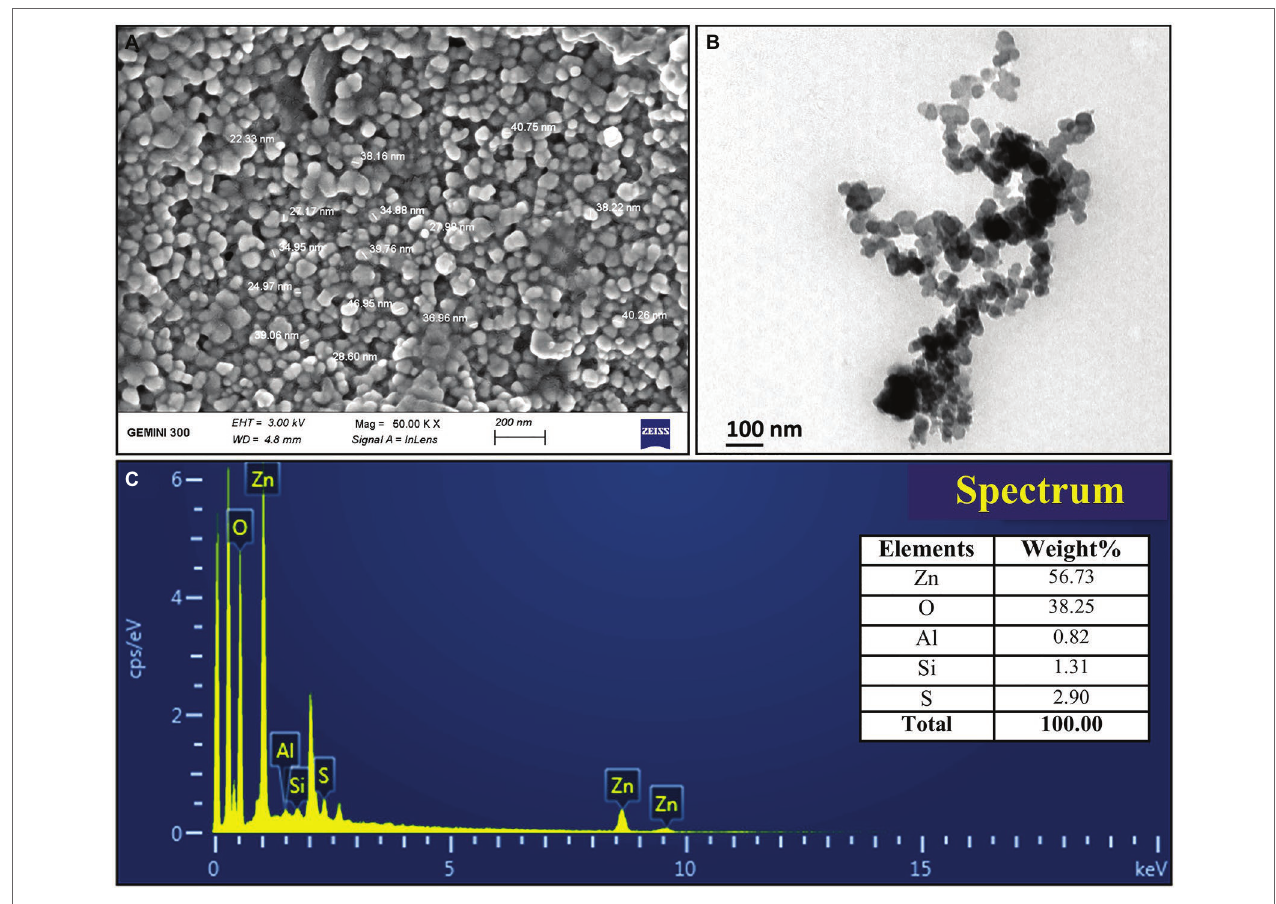
FIGURE 2 | Characterization of biogenic ZnONPs using (A) scanning electron microscopy (SEM), (B) transmission electron microscopy (TEM), and (C) EDX